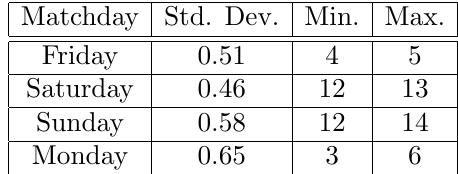
Table 9. Summary statistics for the optimal schedule ( c 2 = 0 .